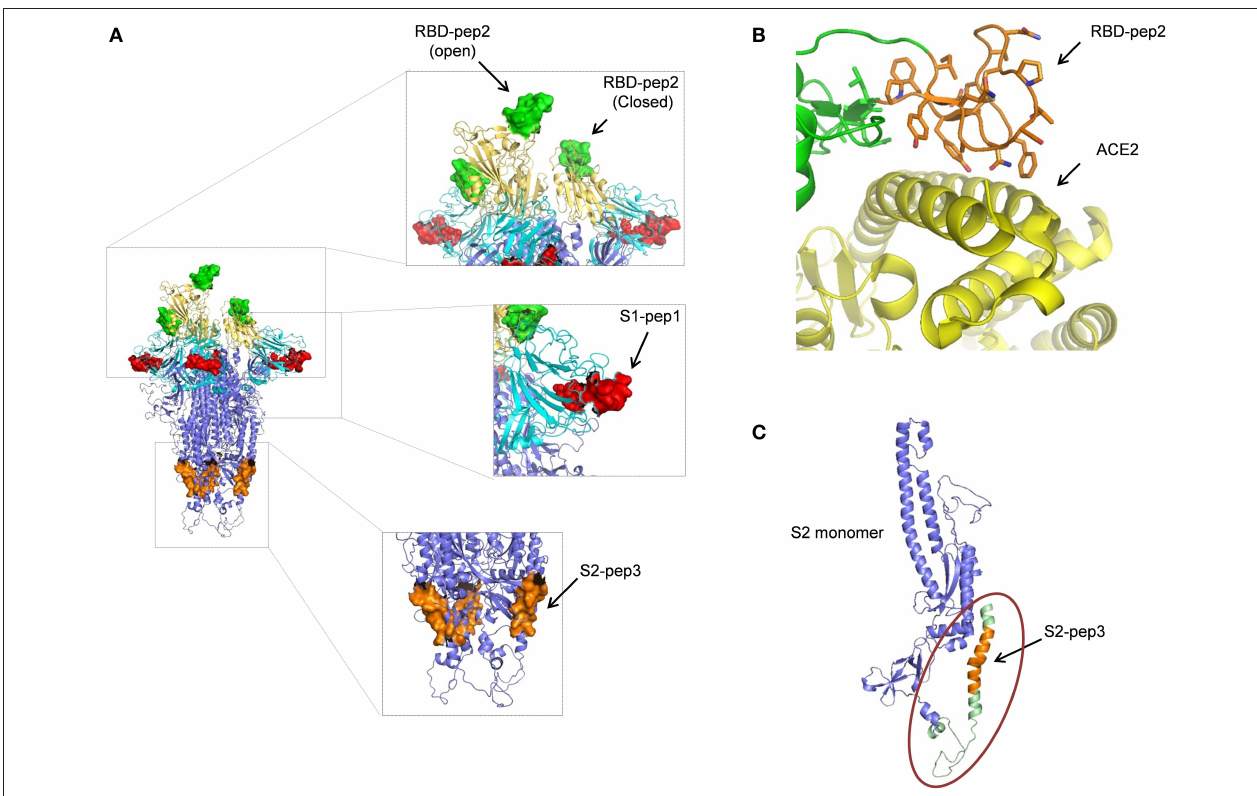
FIGURE 6 | Structural modeling of peptides on SARS-CoV-2S protein. (A) The position of the peptides used in this study is shown on the spike trimer. S1-pep1 is shown in red, that is part of N-terminal domain (NTD) shown in cyan, RBD-pep2 is shown in green, that is part of RBD is shown in yellow (note one RBD is in open conformation and two in closed conformation), and S2-pep3 is shown in orange, that is part of S2 domain. All the peptides are well-exposed to the trimeric spike protein. (B) The RBD-pep2 region in the RBD is shown in orange in the stick model. The RBD-pep2 consists of key residues that are at the interacting interface of ACE2, shown in yellow (PDB: 6M0J). (C) The position of the modeled S2-pep3 is shown in orange in one S2 protomer shown in blue. The structure shown in green in the circle is the C terminal of the spike protein proximal to the membrane that folds back to project upward and forms a helix. All the images were created by using the PYMOL